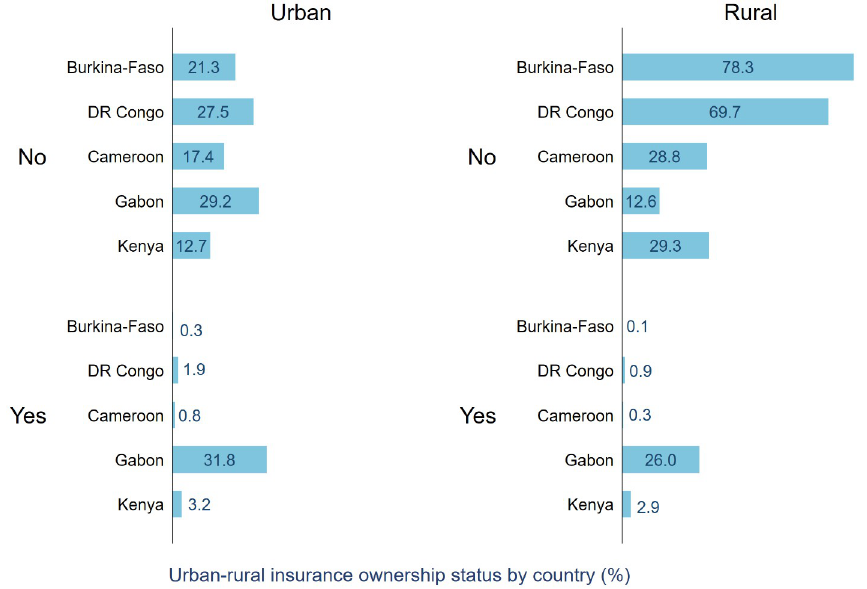
Fig 2. Percentage of participants with health insurance in urban and rural